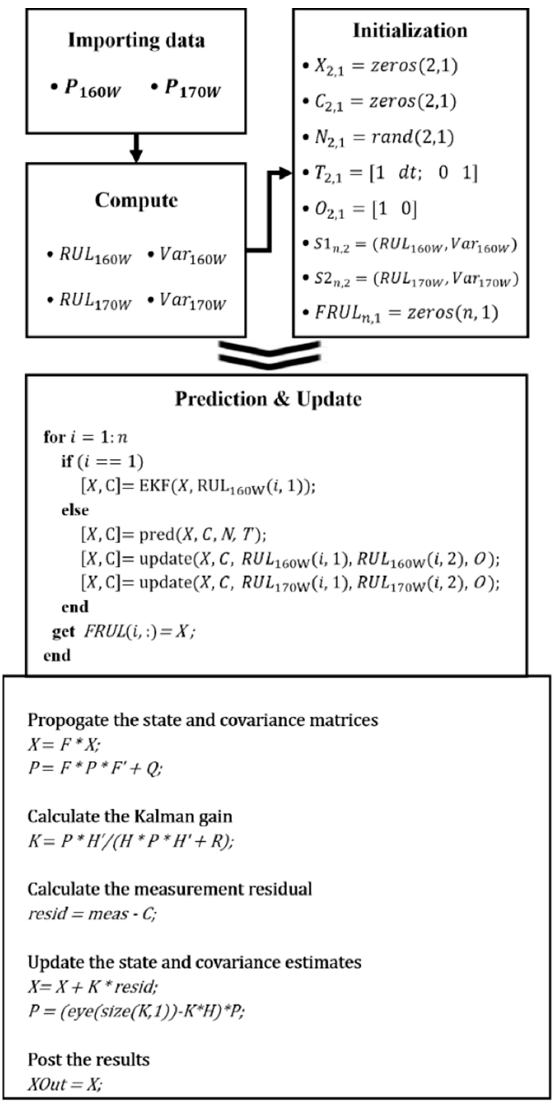
Figure 2. EKF Algorithm for RUL Fusion.